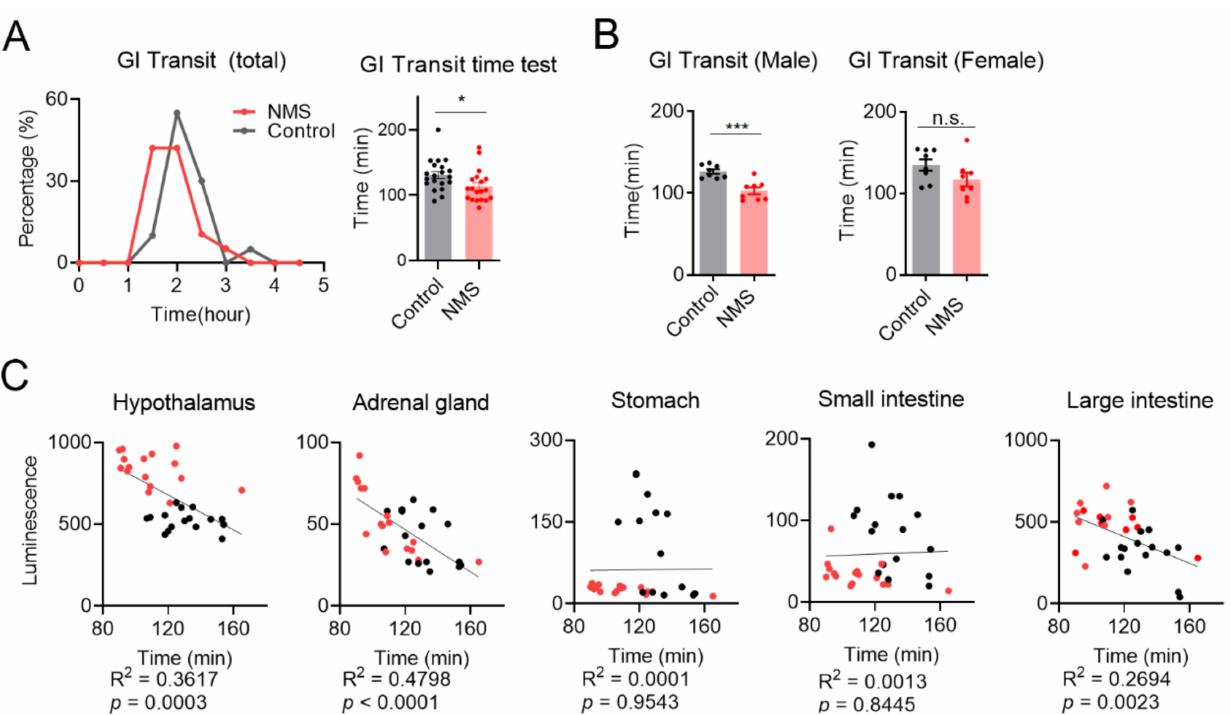
Figure 3. Positive correlation between nNOS expression and whole gastrointestinal transit time. ( A ) Whole gastrointestinal transit time was measured in NMS and control mice. The time of the first observation of carmine-stained feces was designated transit time. Transit time was analyzed by grouping for 30 min (left graph) and compared using individual transit times (right graph) (control, n = 16, NMS, n = 16). ( B ) Transit time from male and female mice was analyzed (male and female: control, n = 8, NMS, n = 8). Each dot indicates data from the individual animals, and data were represented as a mean ± SEM. Statistical analysis was performed using Student’s t -test. n.s.: not significant, *: p < 0.05, and ***: p < 0.001. ( C ) Correlation analysis for nNOS expression and whole gastrointestinal transit time on several organs was conducted. Each dot indicates data from individual mice. Black dot: data from control mice, Red dot: data from NMS mice. Statistical analysis was performed using Pearson R and Student’s two-tailed t